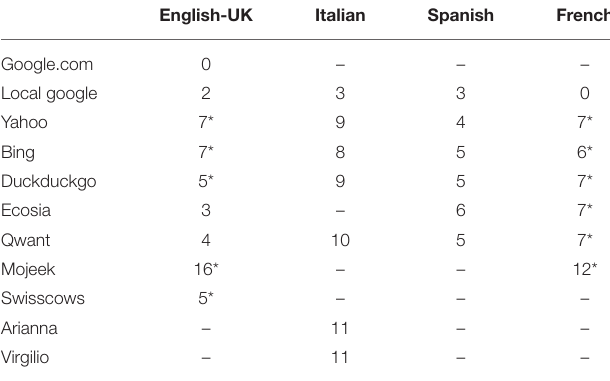
TABLE 2 | Vaccine-negative webpages in different